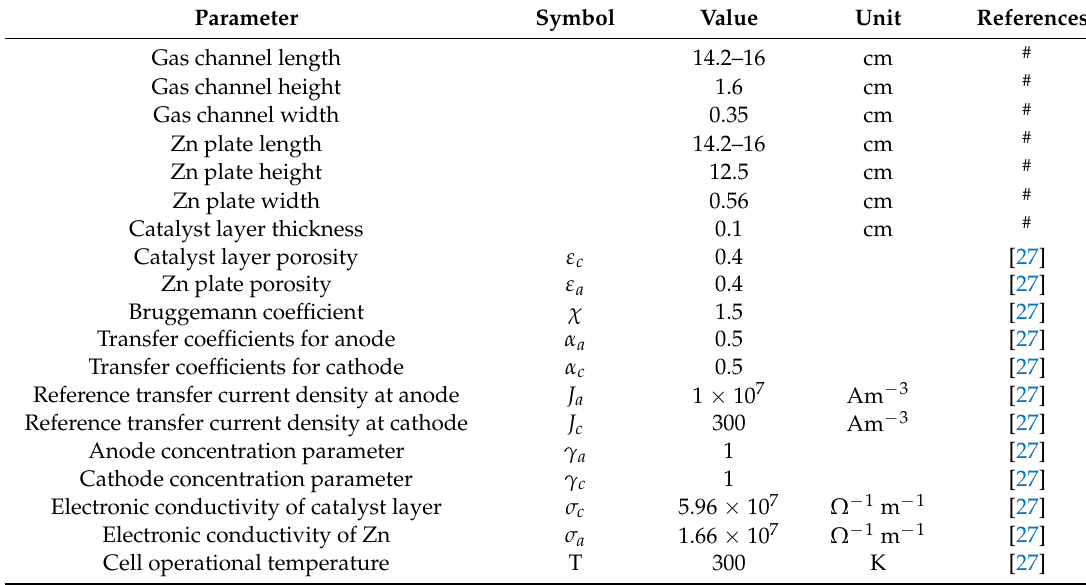
Table 1. Specification of single cell and conditions in